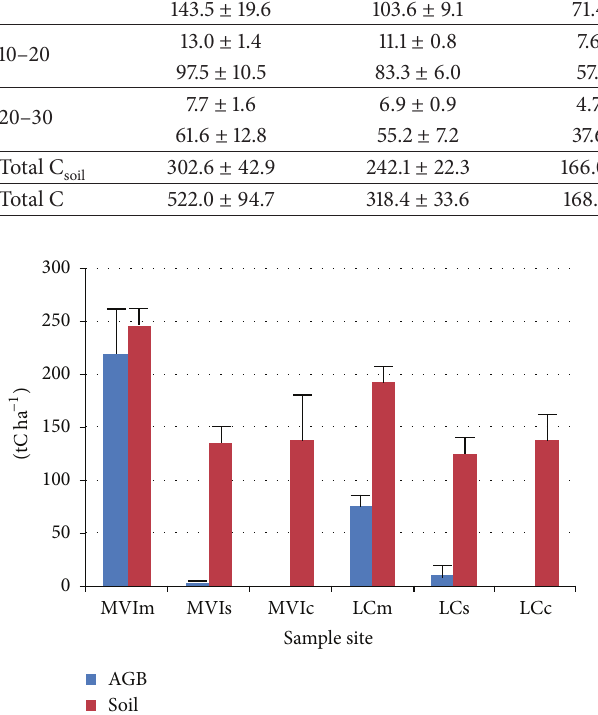
Figure 2: Summary plot of carbon stocks measured in this study, expressed in tCha −1 for both AGB and C soil with bar for positive standard error. Locations indicated: MVIm = MVI mature forest; MVIs = MVI secondary forest; MVIc = MVI clearing; LCm = La Calandria mature forest; LCs = La Calandria secondary forest; and LCc = La Calandria